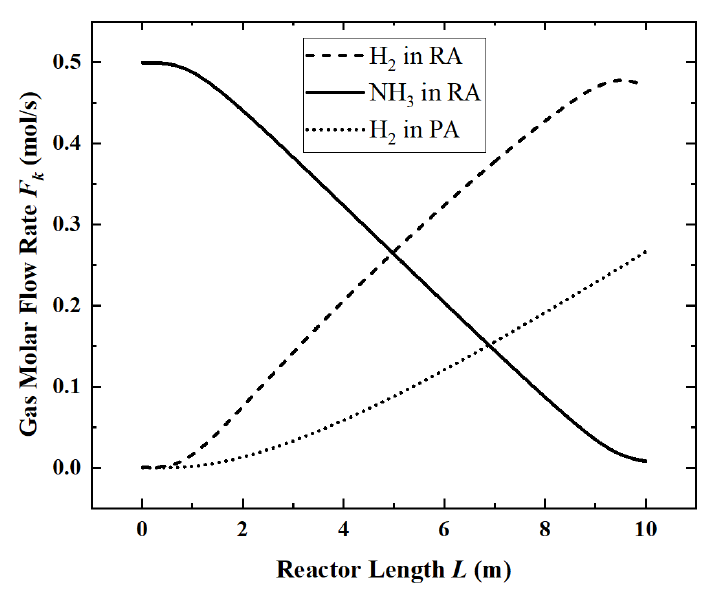
Figure 3. Molar flow rate of each component along the reactor length.